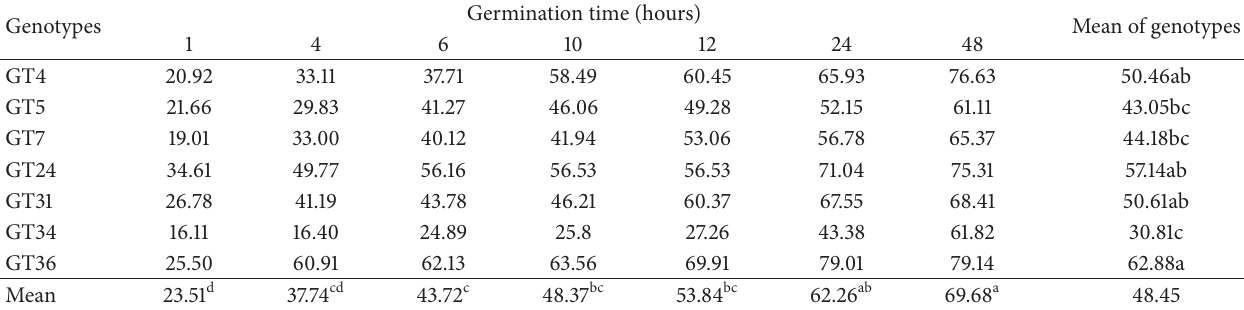
Table 3: Germination rate of cherry laurel genotypes within 48 hours.